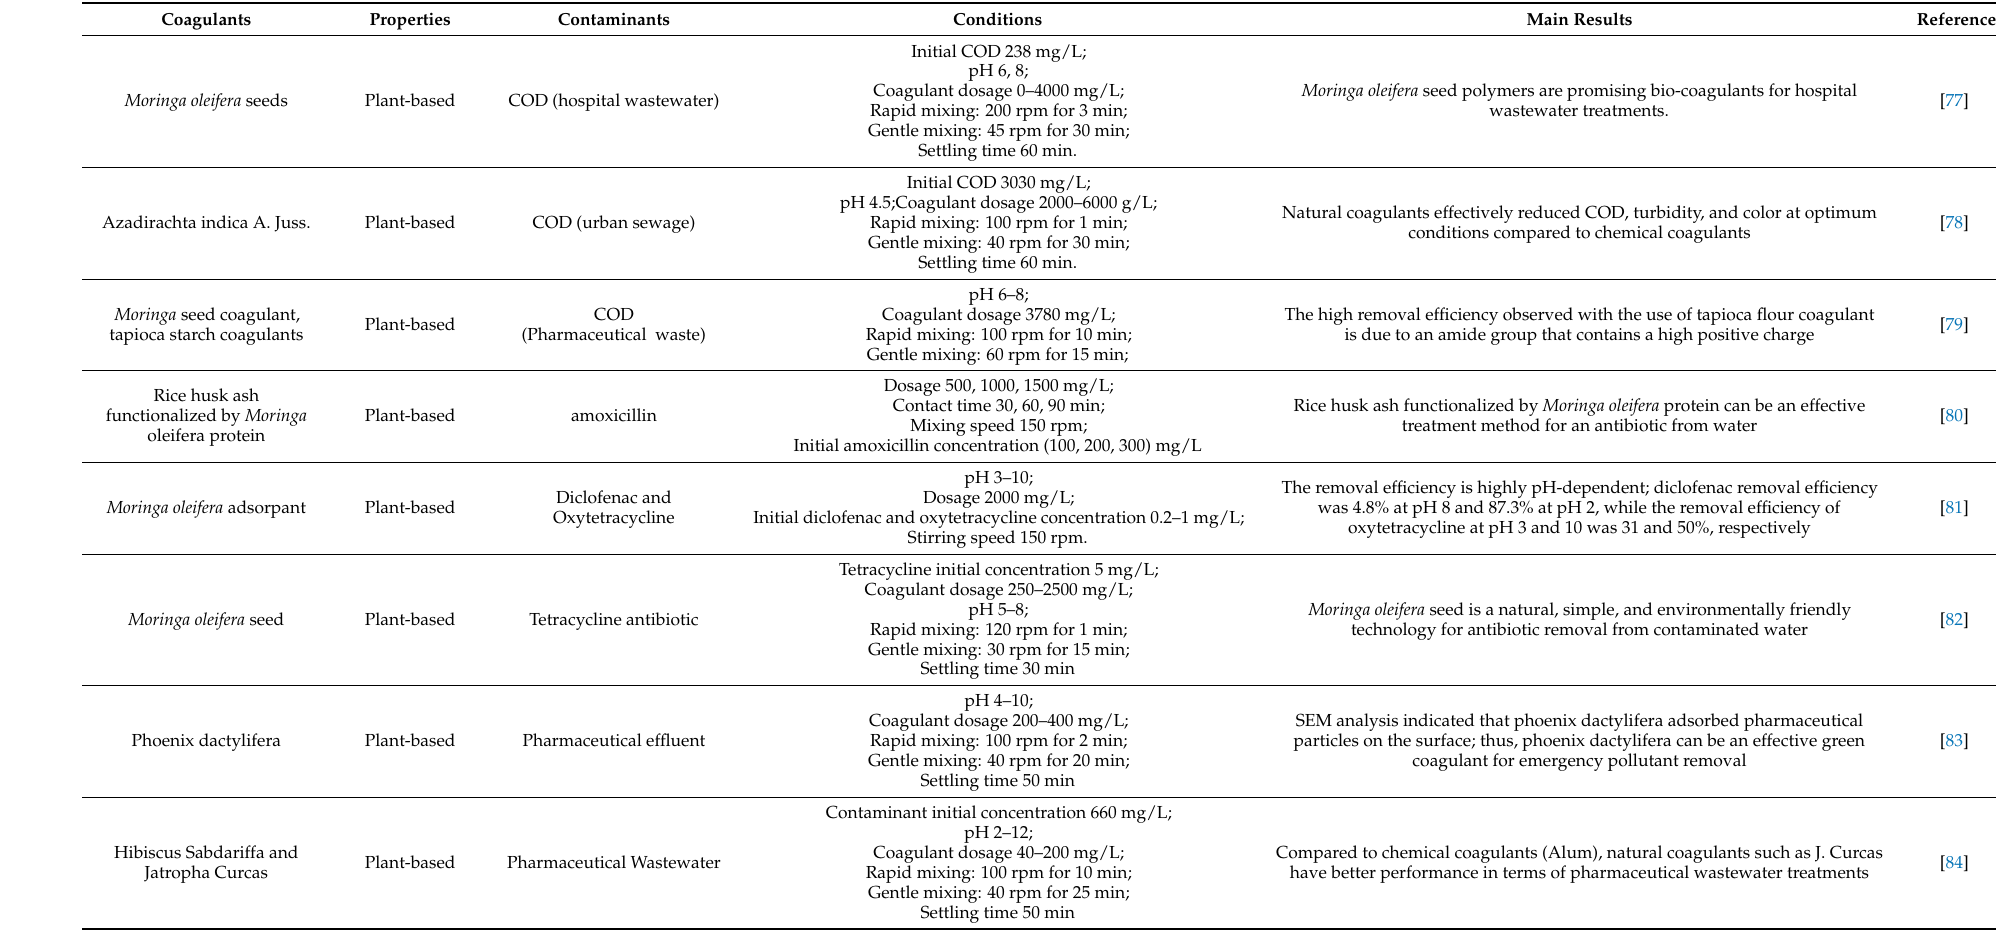
Table 2. Application of natural coagulant for the removal of different types of